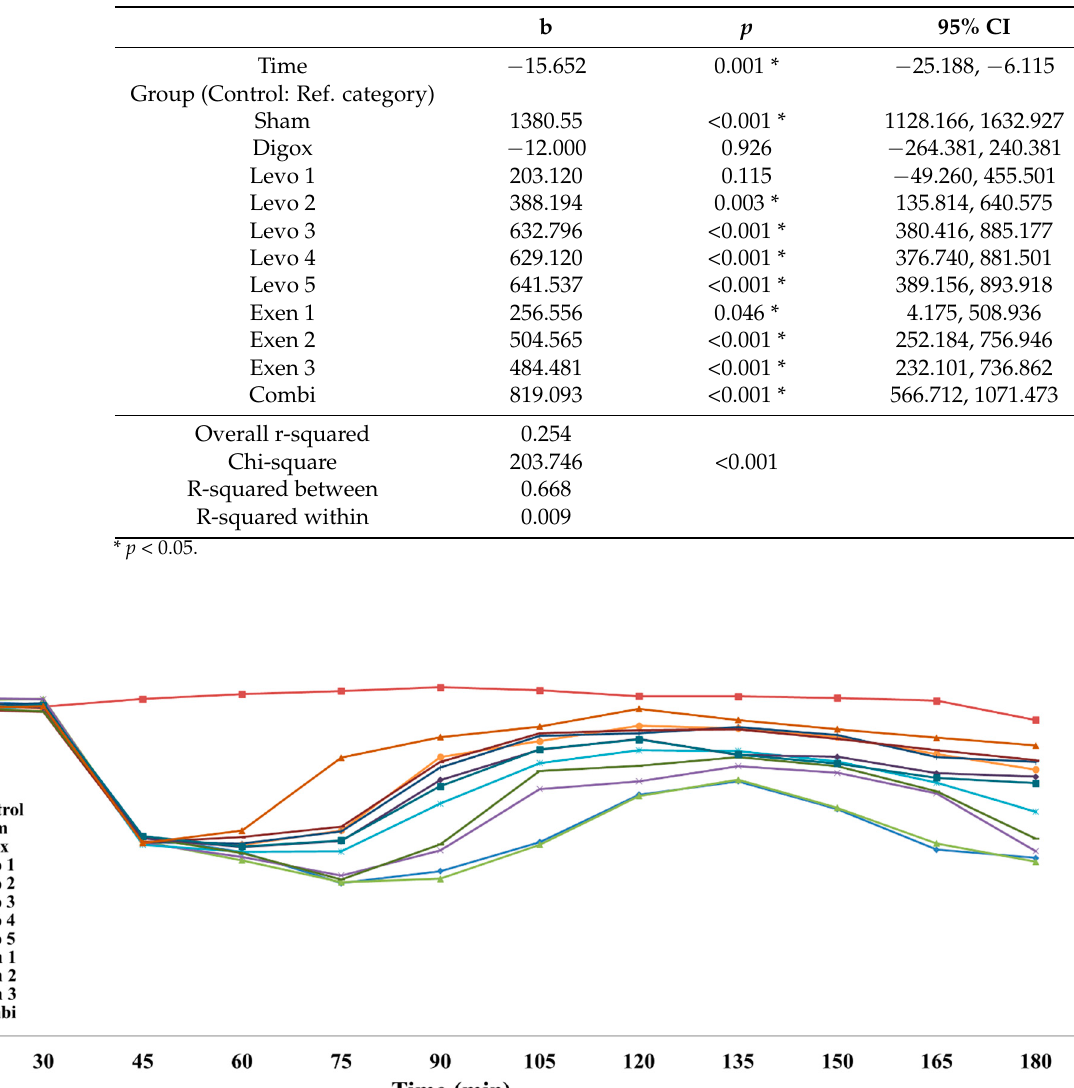
Table 6. Longitudinal analysis for +dP/dt for all groups.